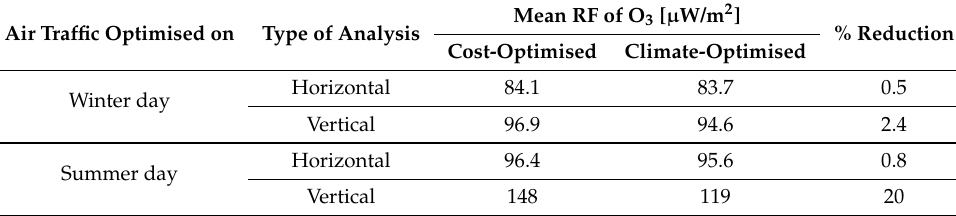
Mean RF of O 3 [ µ W/m 2 ] % Reduction Cost-Optimised Climate-Optimised